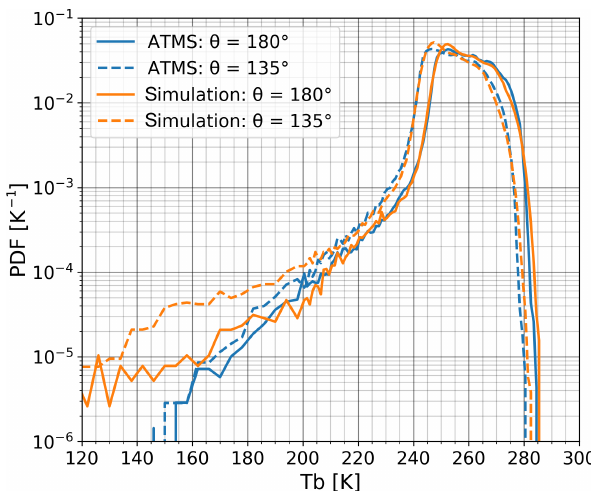
Figure 7. Statistical comparison of simulated and real ATMS chan- nel 21 (183 . 31 ± 1 . 8GHz) measurements, for zenith angles of 180 ◦ (nadir) and 135 ◦ (roughly the one of ICI). Based on data collected between 15 ◦ S to 15 ◦ N August 2015 (all longitudes included, all ATMS day-time data included, 170 randomly selected CloudSat or- bits used). The simulations are shown as monochromatic brightness